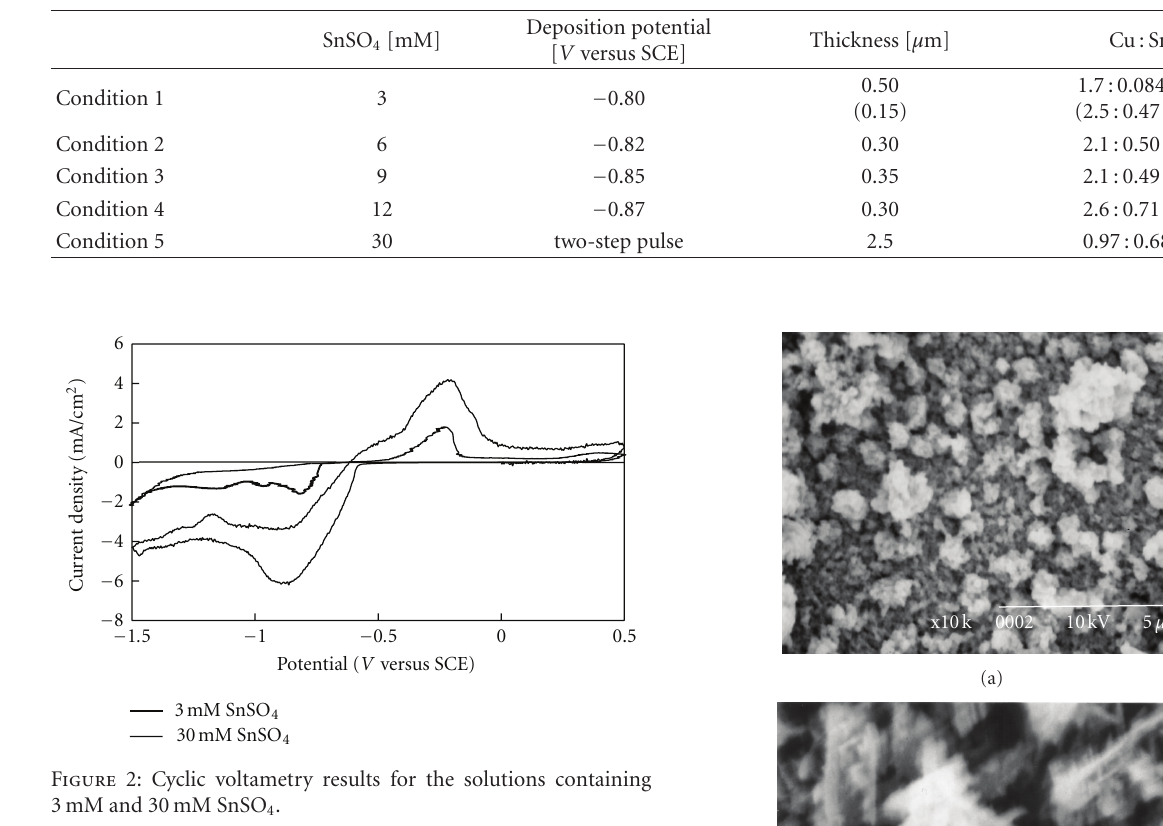
Table 1: Deposition conditions and the corresponding film thickness and composition. CuSO 4 concentration was 10mM and Na 2 S 2 O 3 concentration 100mM. Data in the parentheses are for the film fabricated by 5min deposition. All other data are for the 30-min-deposited films. The deposition potential of condition 5 is a two-step pulse potential with E 1 = − 1 . 3 V versus SCE, E 2 = − 0 . 6 V versus SCE, and each pulse duration was 10s.